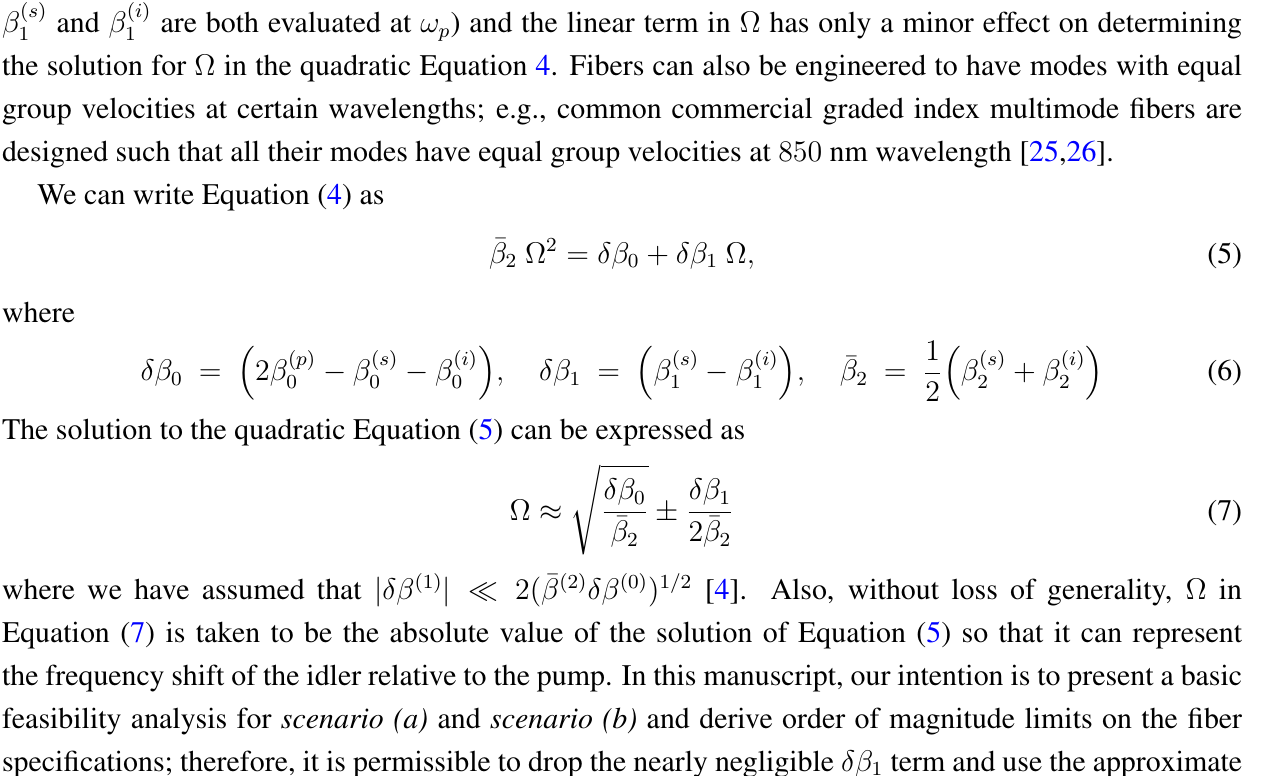
, ω ) pair, where ω p s